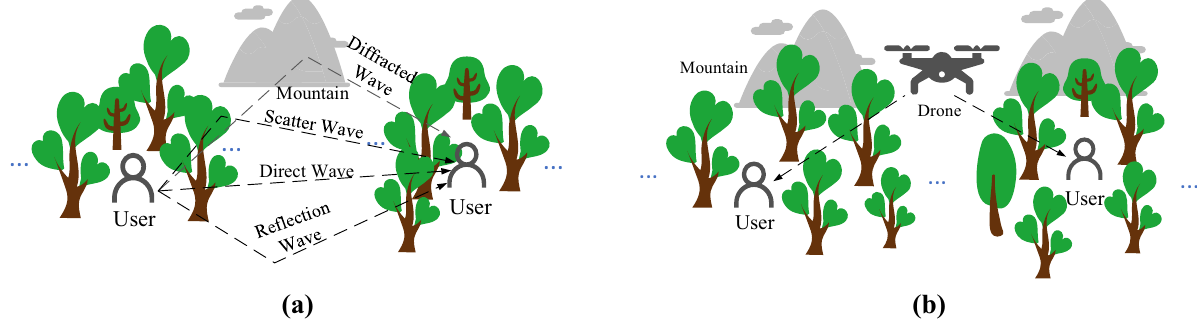
Figure 1. Two communication solutions for the mountainous and dense forest environment: ( a ) the point- to-point link between the rescuers carrying rescue equipment to communicate with each other; ( b ) the UAV air-assisted communication